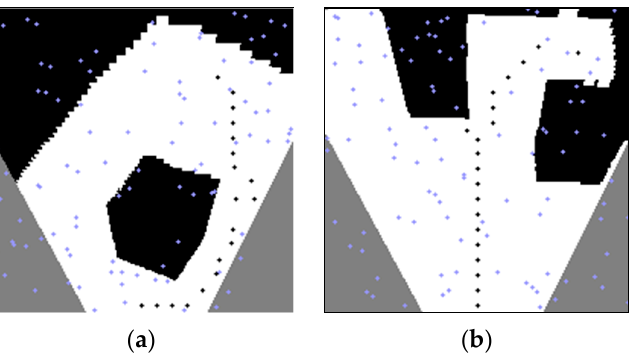
Figure 18. E ff ect of the collision cost C collision in the enhanced A* path: ( a ) having one obstacle at the bo tt om of the environment, ( b ) having two obstacles at the top of the environment.